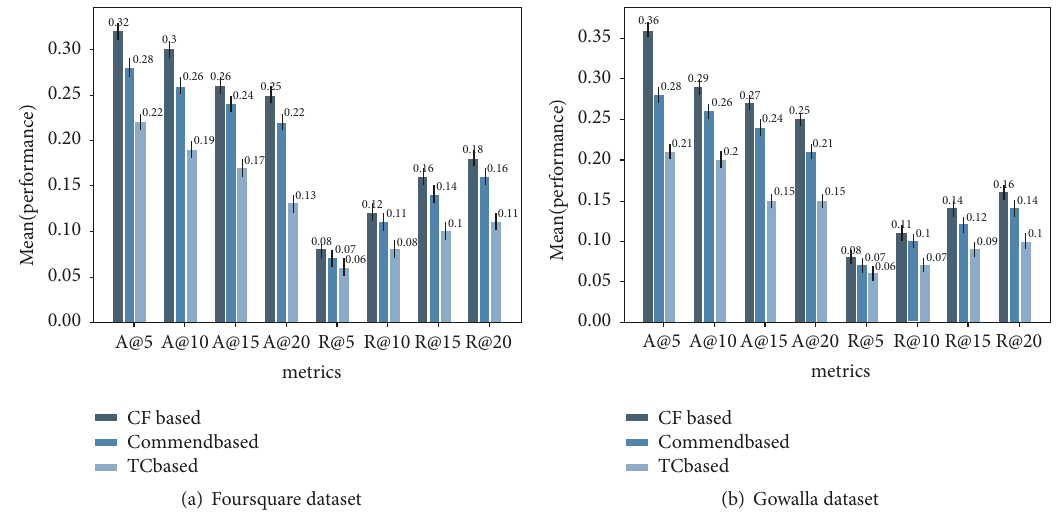
Figure 1: Performance of the top-N (N = 5, 10, 15, and 20) POI recommendations.